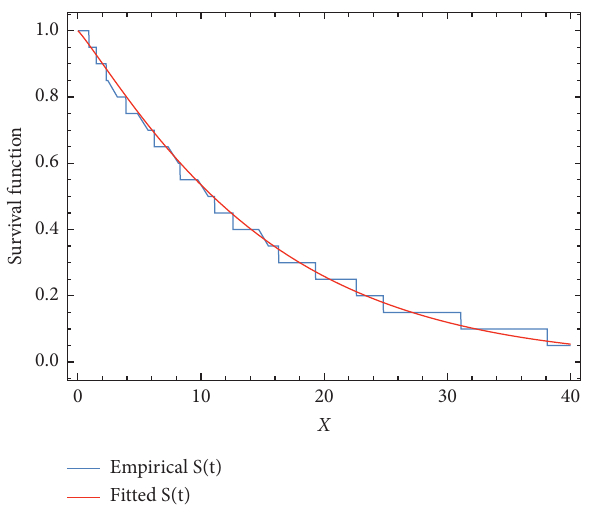
Figure 2: Empirical and fitted survival Table 1: Descriptive statistics for the considered datasets.